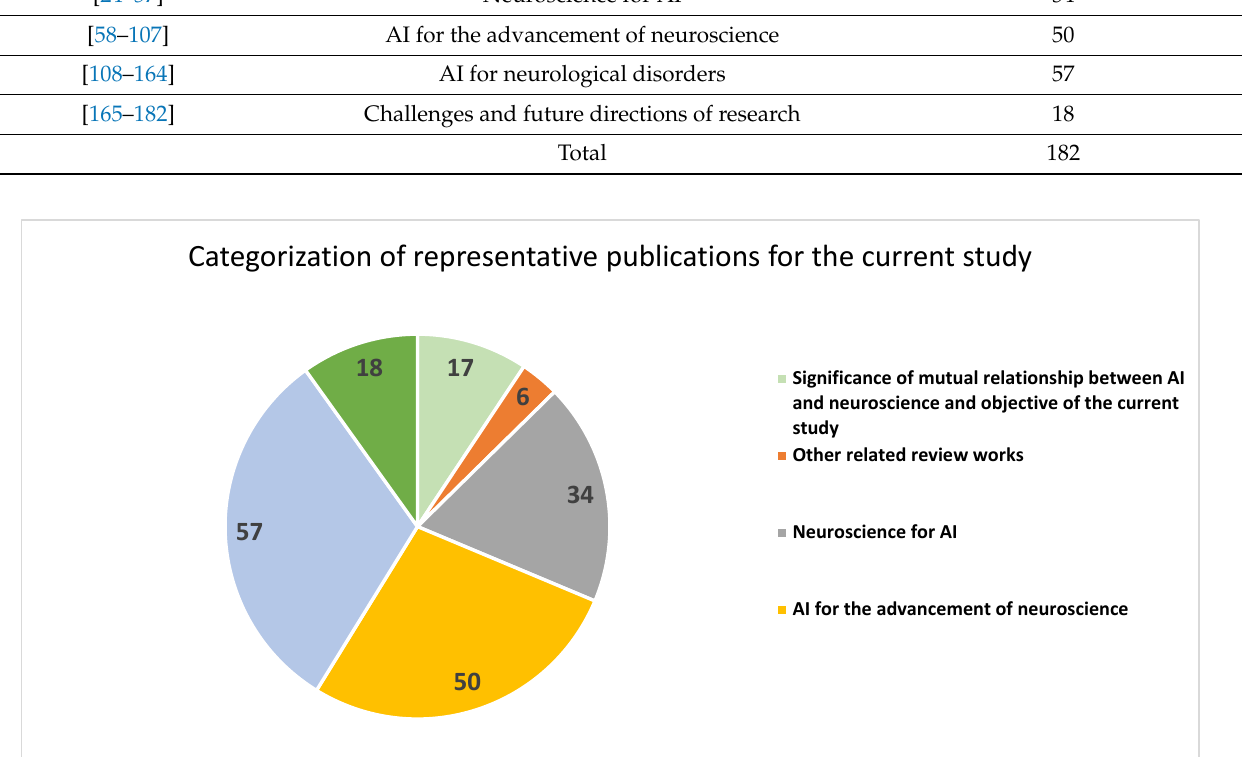
Figure 2. Categorization of representative publications in the current study.